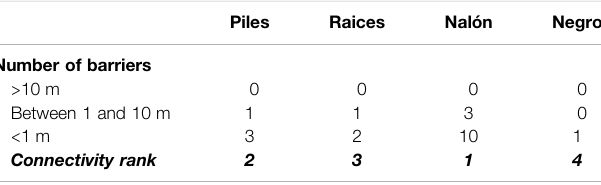
TABLE 2 | River features. Connectivity measured from the number of barriers. Rank scores of river features.